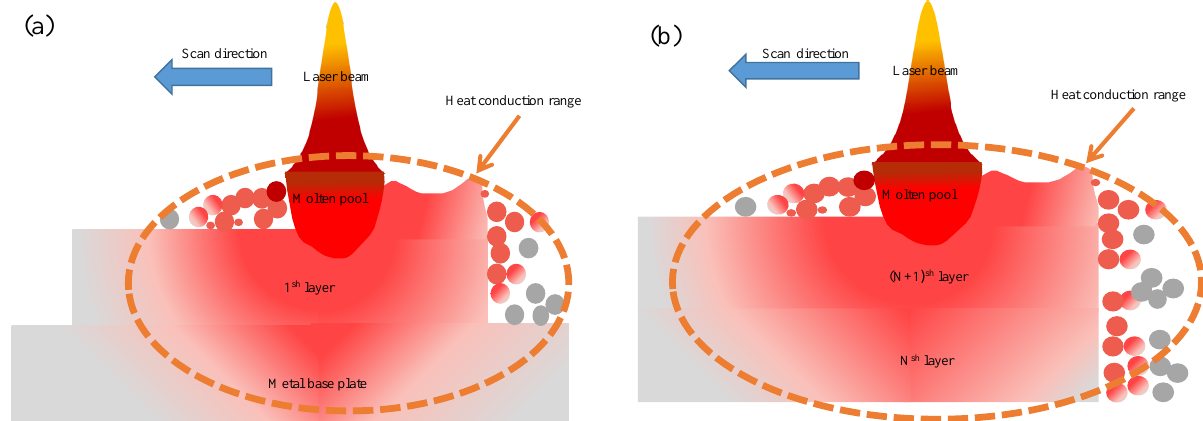
Figure 3. Temperature range of different molding heights. ( a ) Propagation range of metal base plate forming temperature; ( b ) The temperature propagation range of specimen-forming